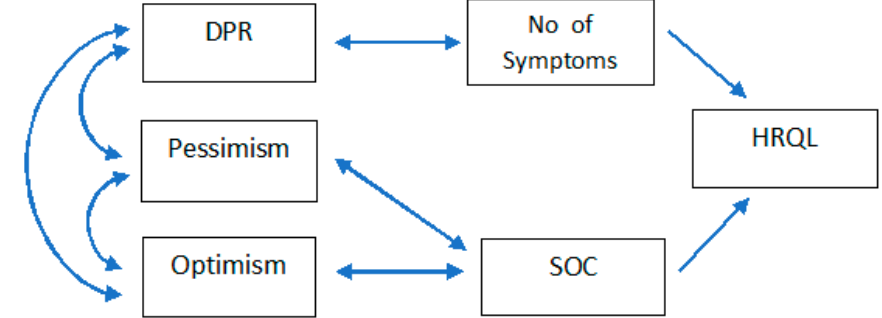
Figure 1. Initial model of the relationship between SOC, the number of symptoms, and HRQL analysed by contrast. DRP: Doctor–patient relationship; SOC: Sense of coherence; HRQL: Health-related quality of life.